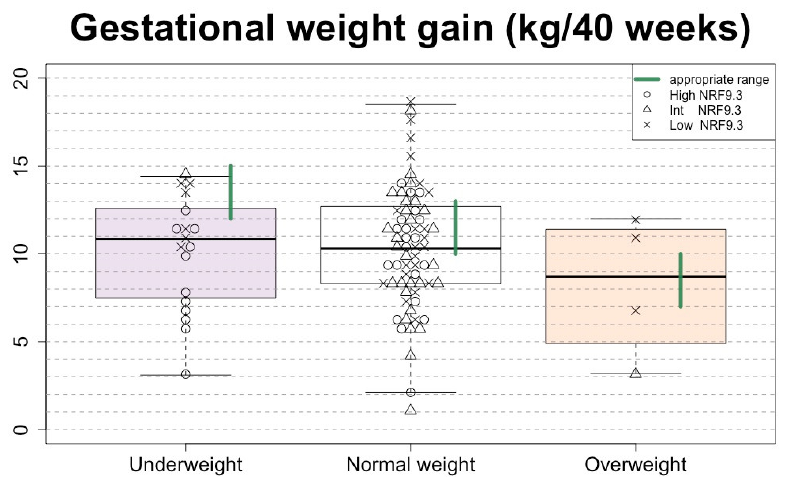
Figure 3. Gestational weight gain (GWG) according to the pre-pregnancy BMI category, with presentation of the individual’s diet quality. Each subject ( n = 91) is shown in the box-and-whisker plots, with the boxes indicating the median and interquartile range and the whiskers denoting the range. Open circles, open triangles, and crosses indicate high, intermediate, and low NRF9.3 scores, respectively. Green lines indicate the BMI-specific optimal GWG ranges (12–15 kg, 9.9–12.8 kg, and 7–10 kg for underweight, normal weight, and overweight) determined by [5]. The high quality of the diet decreased the excessive GWG but did not increase the proportion of adequate GWG (Figure 4).